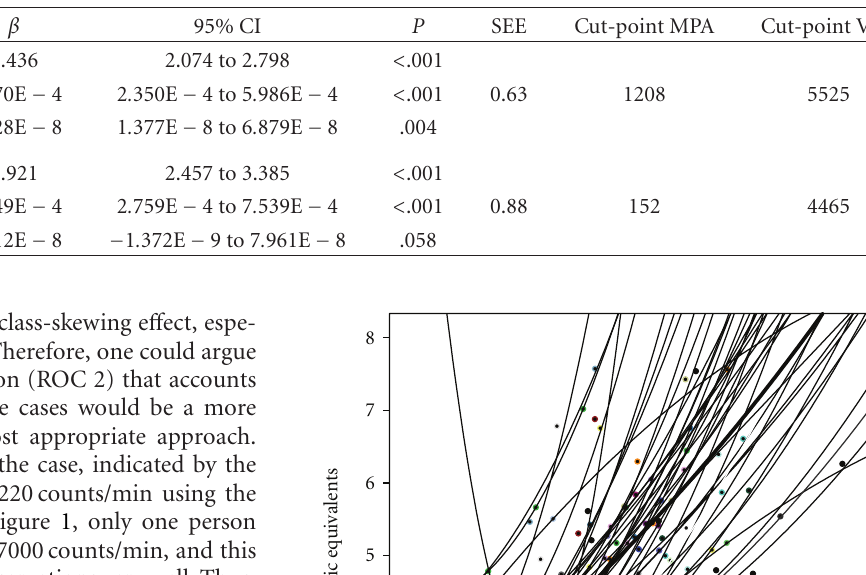
Table 5: The suggested regression equations and cut points obtained for two subgroups of di ff ering age; group 1: age 24–42 (35.7 ± 5.7) years, n = 20; group 2: age 43–62 (50.0 ± 5.5) years, n = 22. β : regression coe ffi cient; CI: confidence interval; SEE: standard error of the